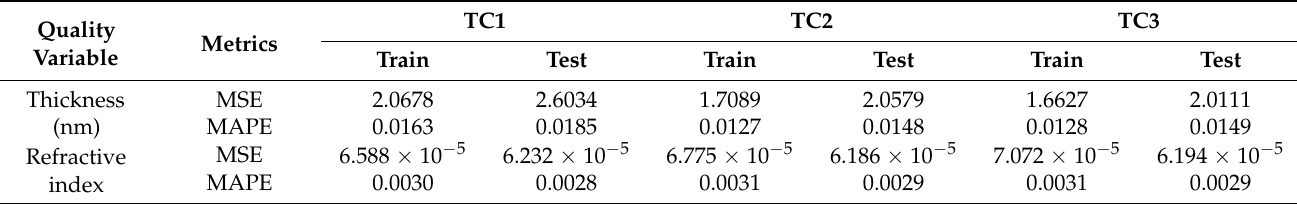
Table 2. Predicted quality under different training conditions.